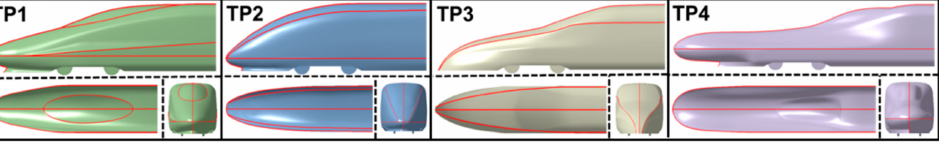
Figure 3. Different streamlined structures of the